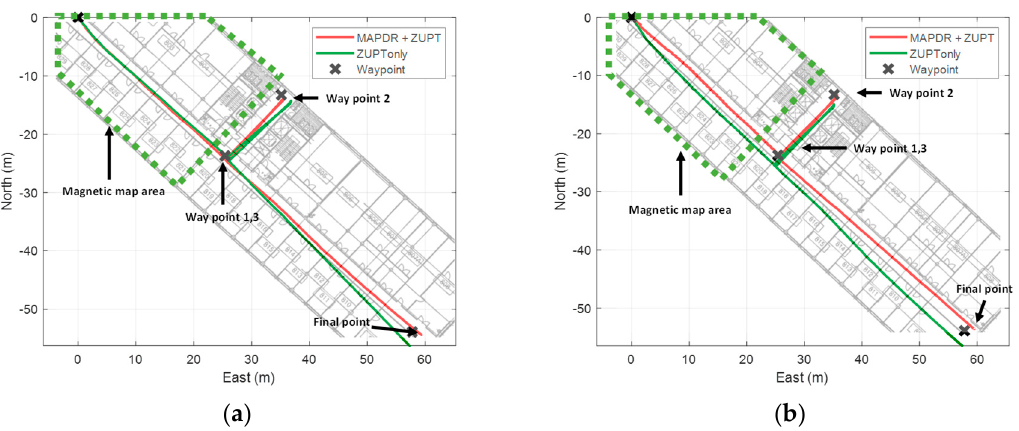
Figure 11. The experiment result of MAPDR with site 1 partial magnetic map ( a ) experiment 1 ( b ) experiment 2.